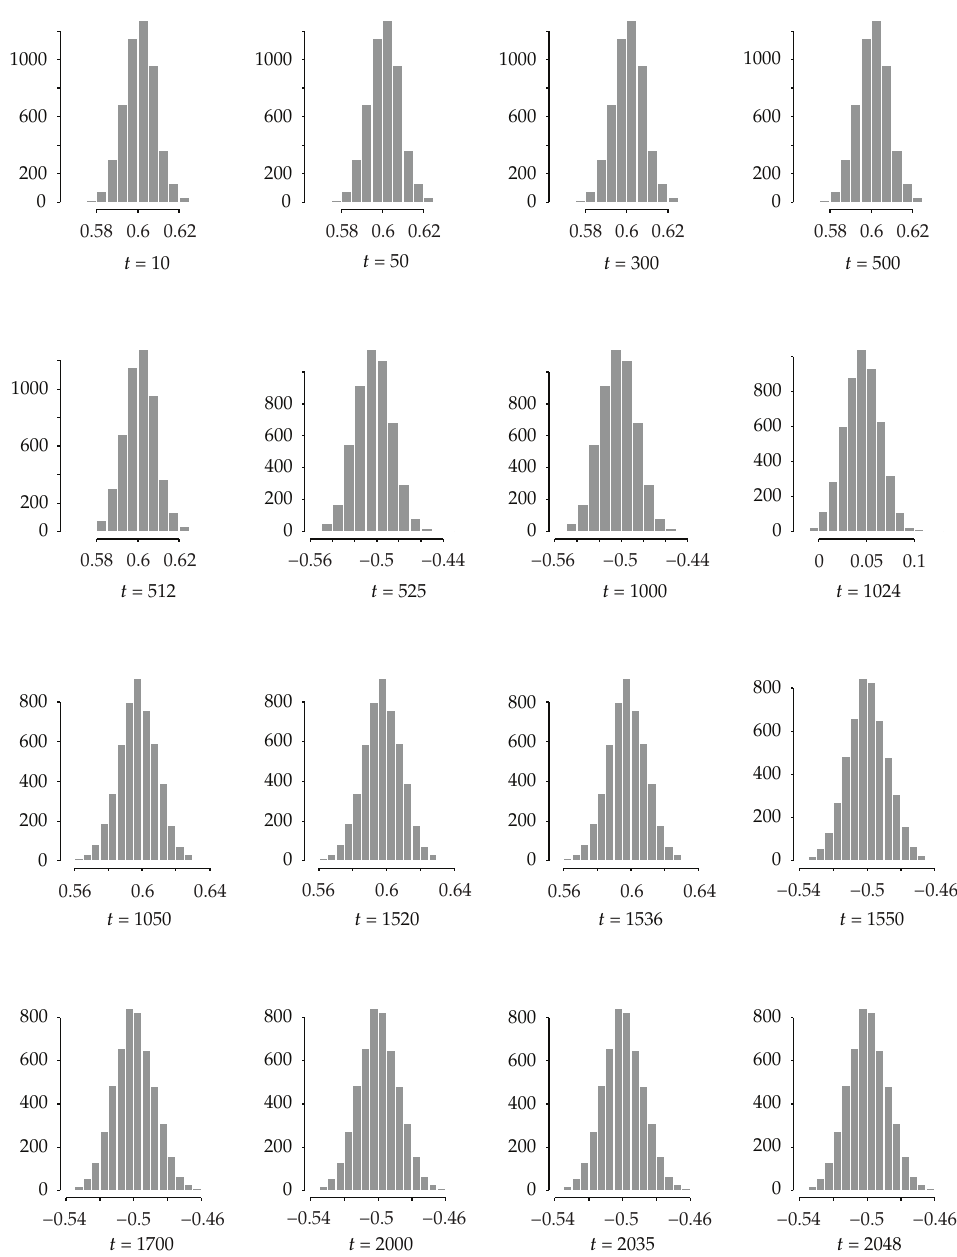
Figure 22: Example 5.3: Histograms of nonlinear estimate of δ 1 at some points of (cid:7) 0, 1 (cid:8)